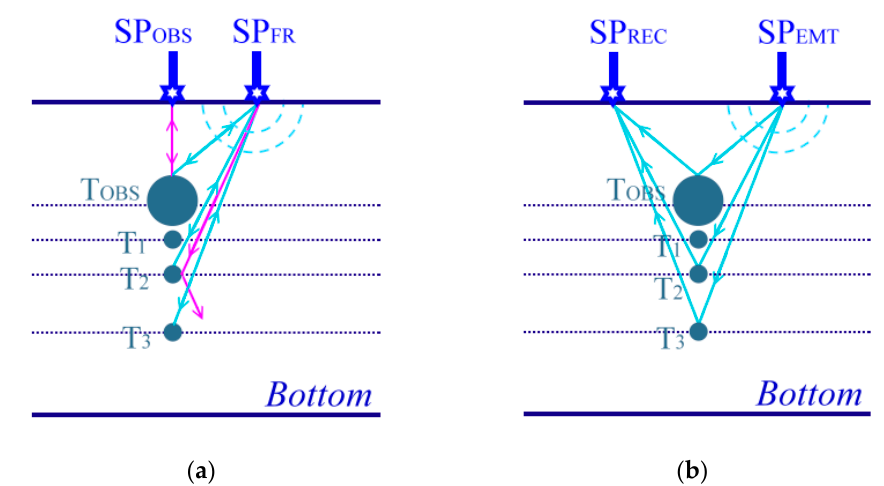
Figure 7. Schematic of ( a ) B-mode and ( b ) pitch/catch mode scans and the theoretical echo-paths for the active transceiver(s). SP stands for scan position, and subscripts OBS, FR, EMT, and REC are the obstacle, obstacle-free, emitter, and receiver, respectively.